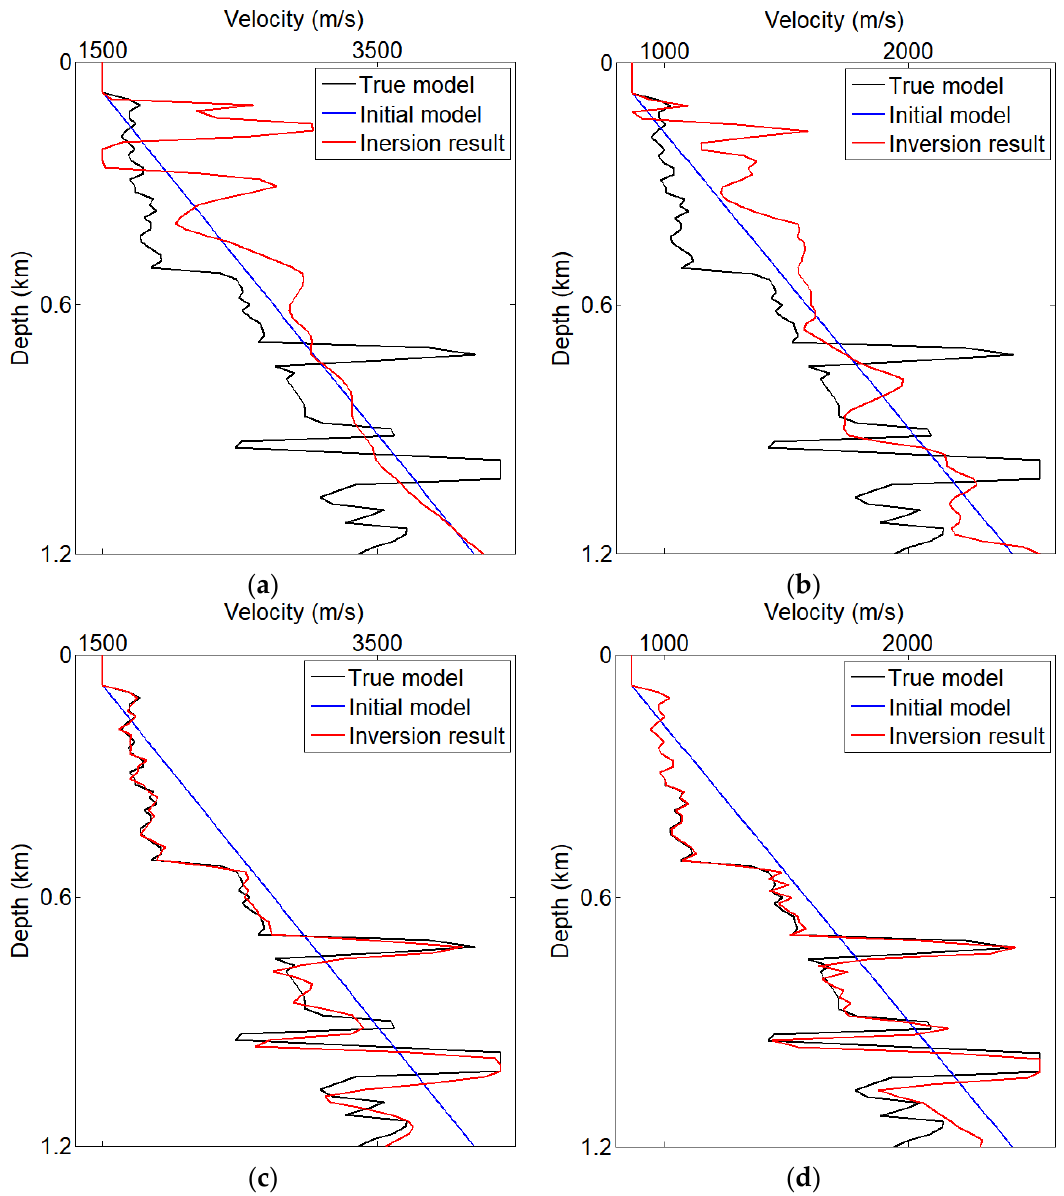
the cycle skipping.